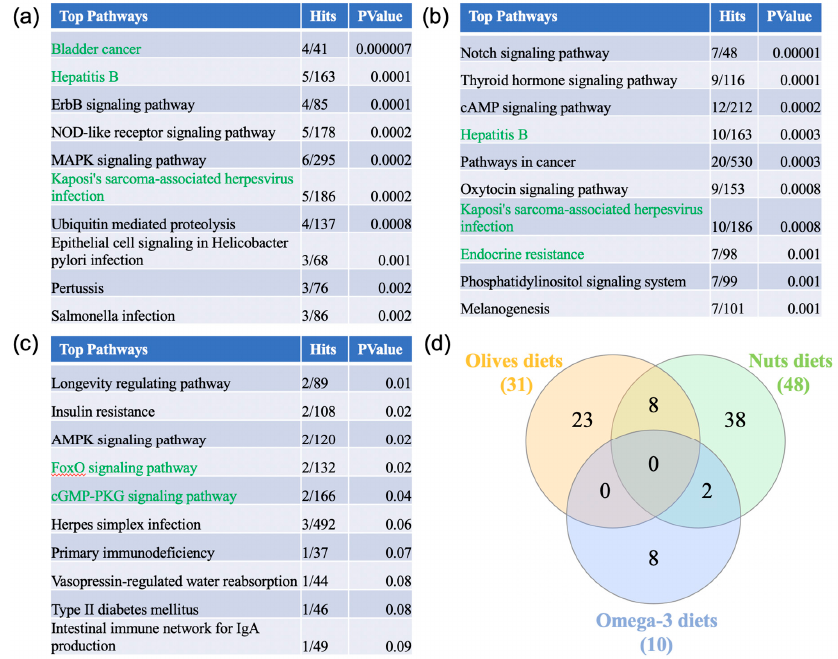
Figure 2. Venn diagram analysis of the genes up and downregulated in olive- and omega-3-supplemented diets. ( a ) and ( b ) . Genes in olive-supplemented diets: The genes downregulated ( a ) and upregulated ( b ) in the olive oil or leaf extracts arrays were downloaded from BSCE and used to create a Venn diagram using the following website http://www.interactivenn.net/. ( c ) and ( d ). Genes in Omega-3-supplemented diets: The genes downregulated ( c ) and upregulated ( d ) in the fish oil or eicosapentaenoic acid (EPA)/ docosahexaenoic acid (DHA) studies were downloaded from BSCE and used to create the Venn diagrams.